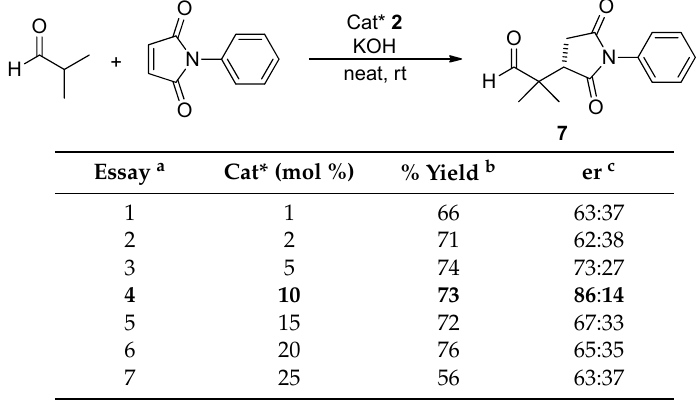
Molecules 2017 , 22 , 1328